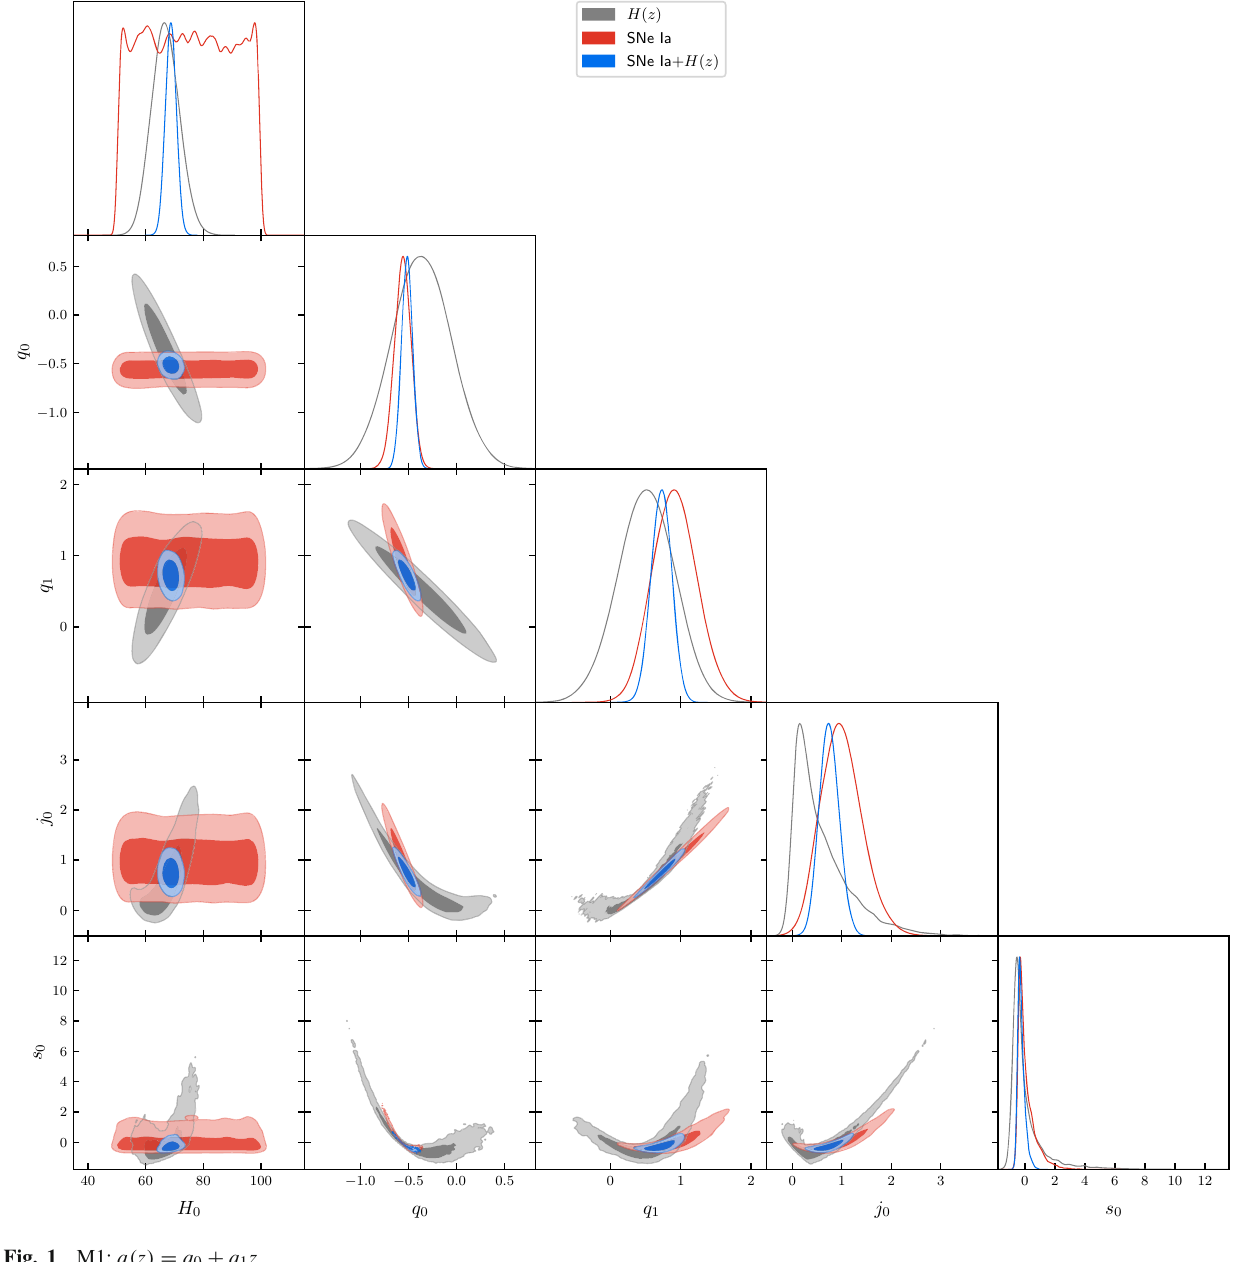
Fig. 1 M1: q ( z ) = q 0 + q 1